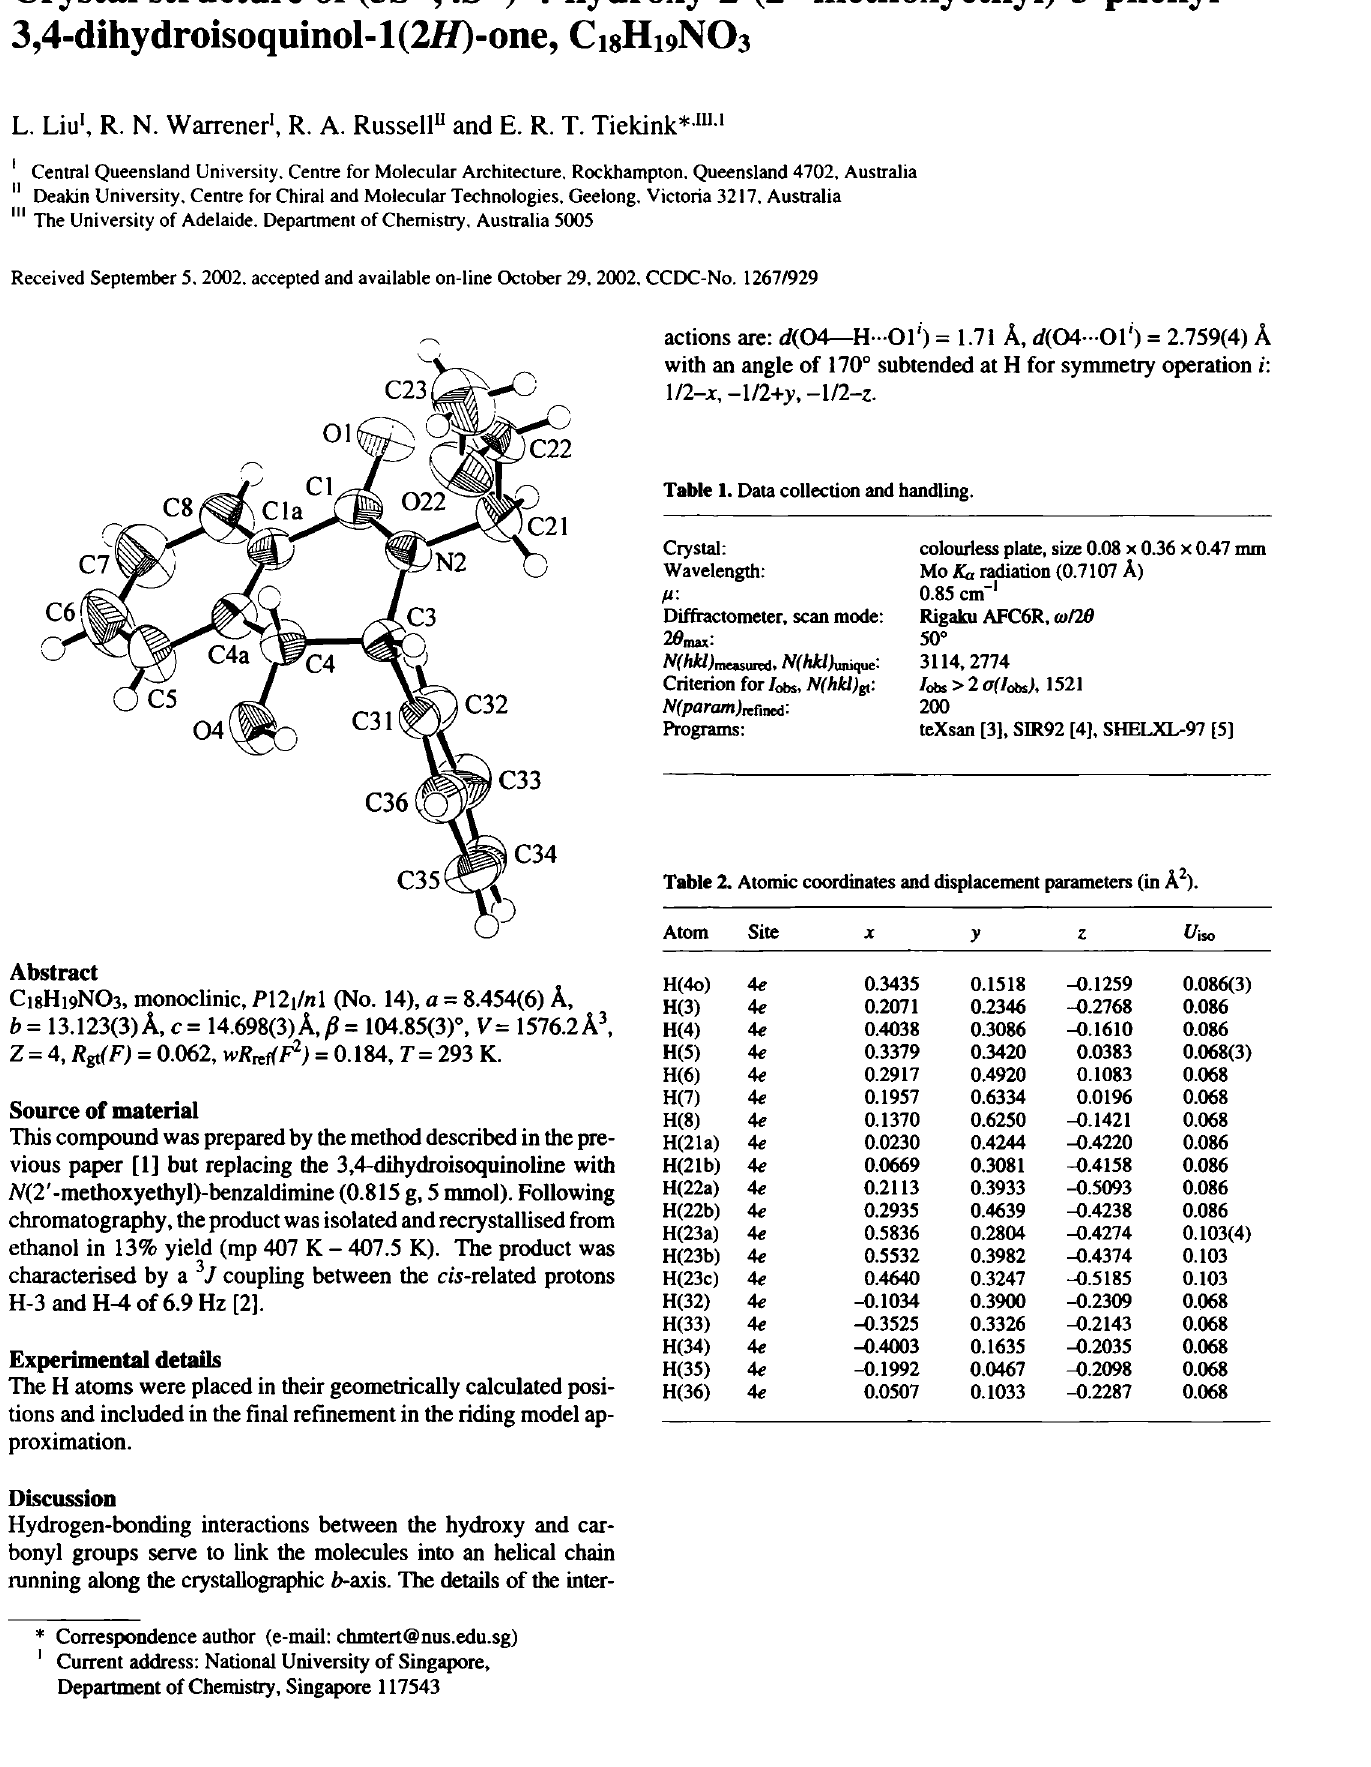
Table 1. Data collection and handling.